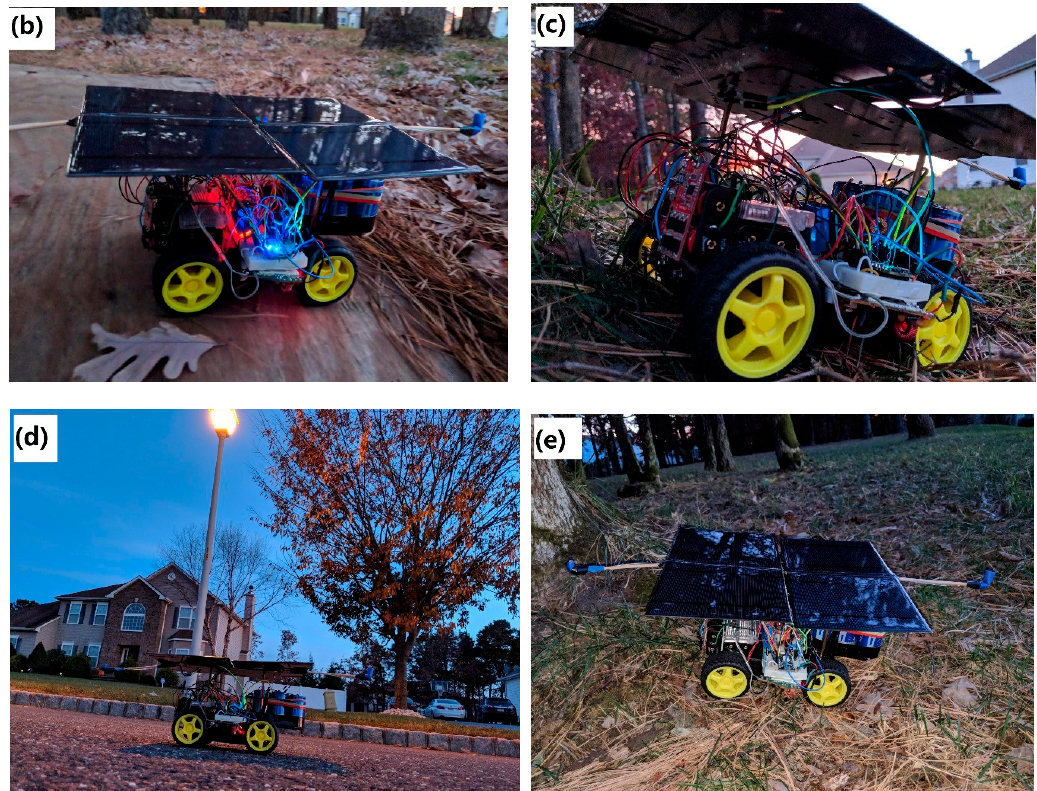
Figure 2. Rover hardware and design. Circuitry containing RC receiver and motor driver. ( a – e ) Circuitry containing Particle Photon board, voltage divider for voltage measurements, toroid coil to centralize magnetic field associated with Hall sensor, balance board to power MCU, power switch relay, and battery management system for Li-ions. Overall pictures of Rover size and environmental application.